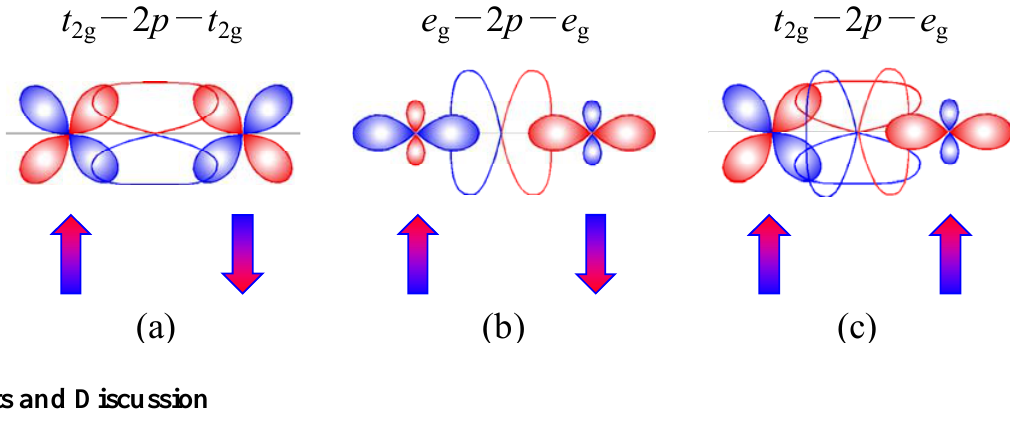
Figure 1. Magnetic interaction between octahedral site transition-metal ions via an oxygen ion according to the Kanamori-Goodenough rule (180 ° cation-anion-cation interactions). )-O-M( t ). Half filled t orbitals of cations (a) Antiferromagnetic interaction of M( t 2g 2g 2g overlapping p  produce the antiferromagnetic interaction; (b) Antiferromagnetic interaction of M’( e )-O-M’( e ). Half filled e orbitals overlapping p  mediate the strong g g g antiferromagnetic interaction; (c) Ferromagnetic interaction of M( t )-O-M’( e ). 2g g － 2 p － t t 2g